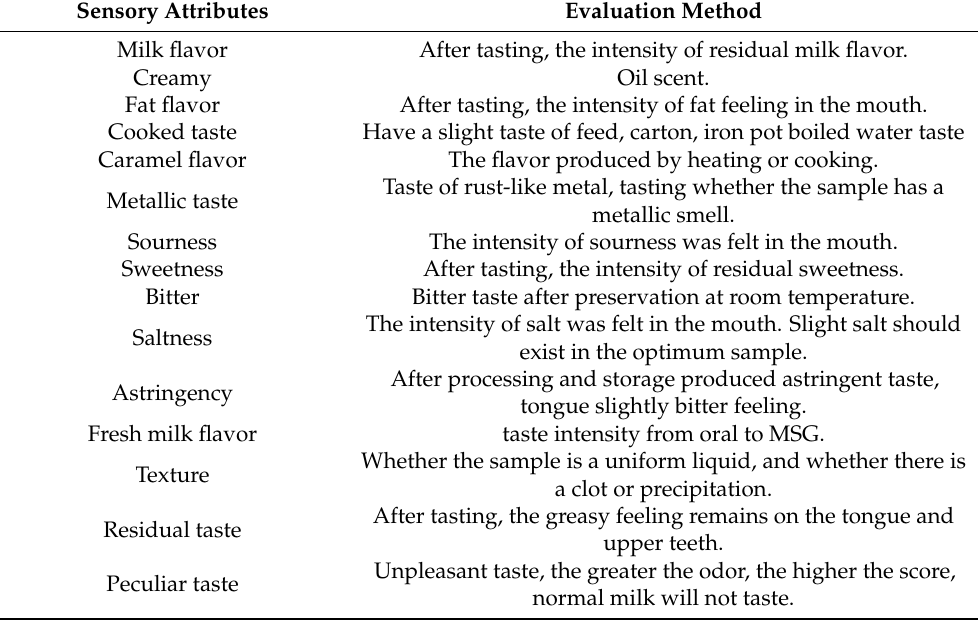
Table 2. Descriptive sensory language for pasteurized